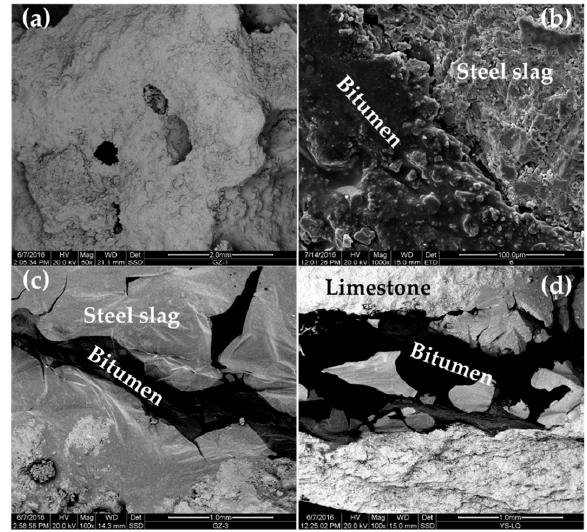
Figure 15. SEM images: ( a ) steel-slag aggregate; ( b ) permeable steel-slag–bitumen mixture; ( c ) steel- slag–bitumen sandwich interface; and ( d ) limestone–bitumen sandwich interface.